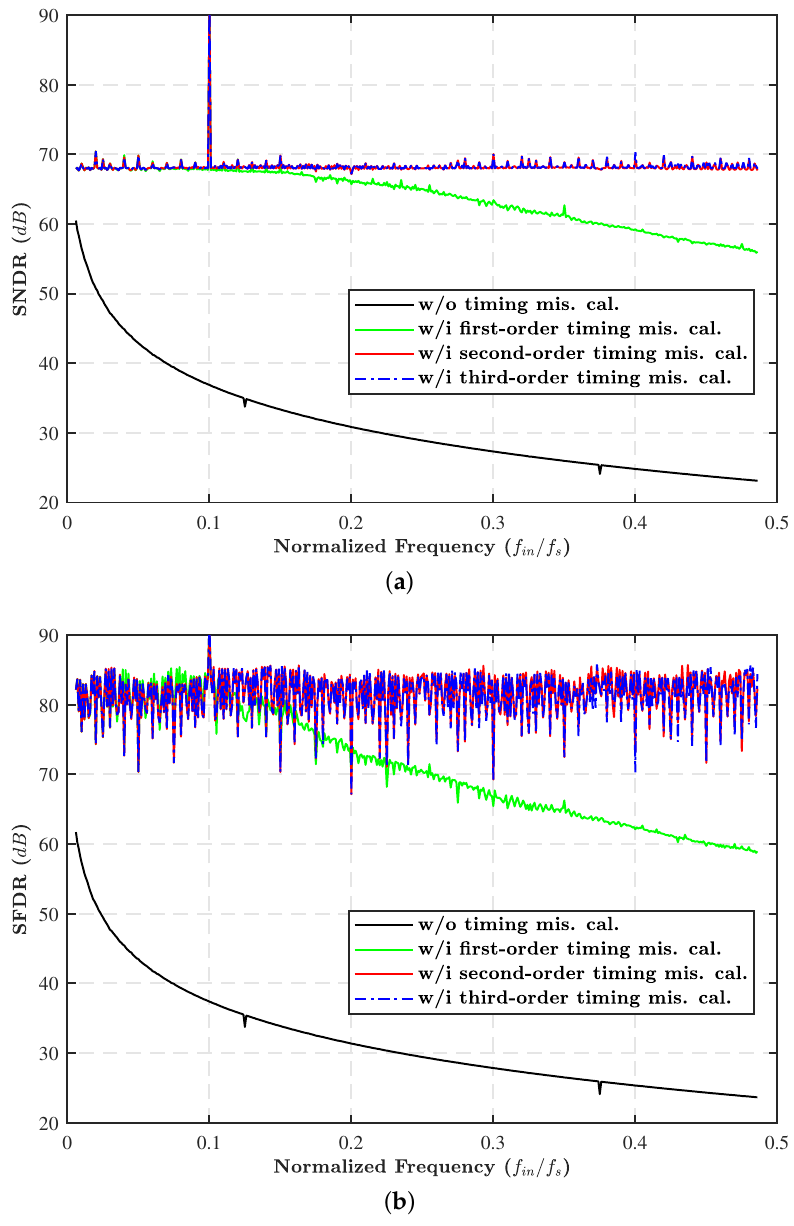
Figure 12. The results of the proposed calibration method versus different input frequencies: ( a ) SNDR; ( b )